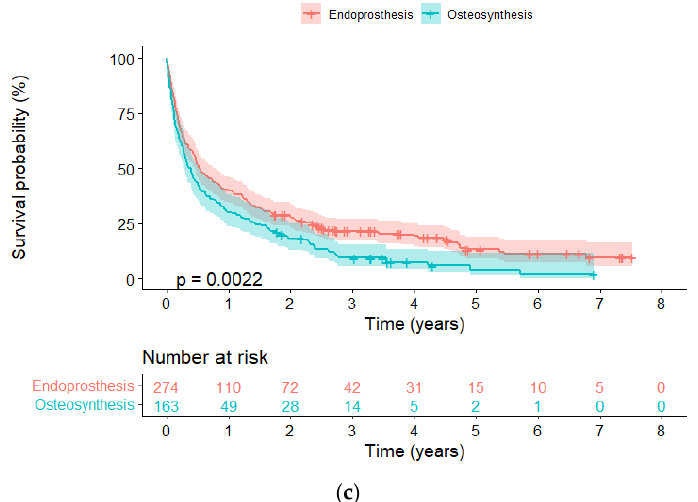
Figure 5. ( a – c ) Kaplan-Meier analysis illustrating cumulated overall survival for all patients ( n = 457). Overall 1-year survival for the entire cohort was 37% (95% CI: 33–42) and 44% (95% CI: 38–50) versus 29% (95% CI: 23–36) for patients treated at MTC or SSC, respectively ( p < 0.0001), and 40% (95% CI: 34–46) versus 30% (95% CI: 24–38) for patients receiving endoprostheses and osteosyntheses, respectively ( p < 0.0022).